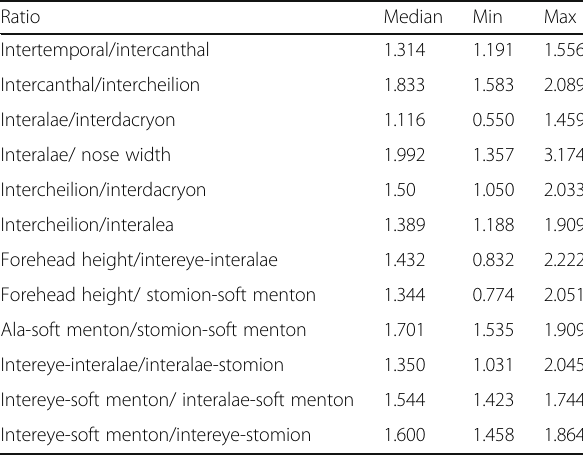
Table 7 Median and range of each facial ratio of professional